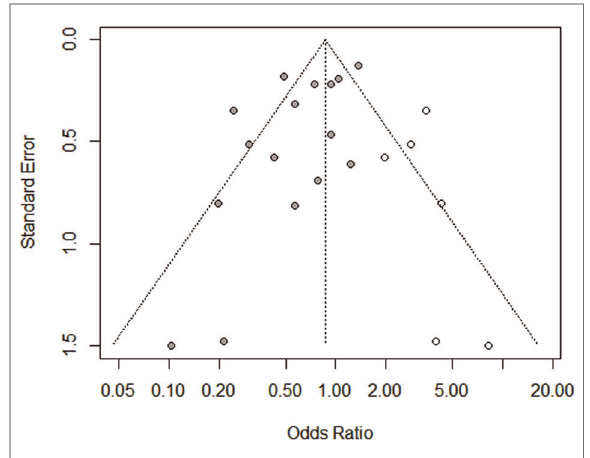
FIGURE 5 Funnel plot for trim-and- fi ll analysis. Hollow circle means added simulated